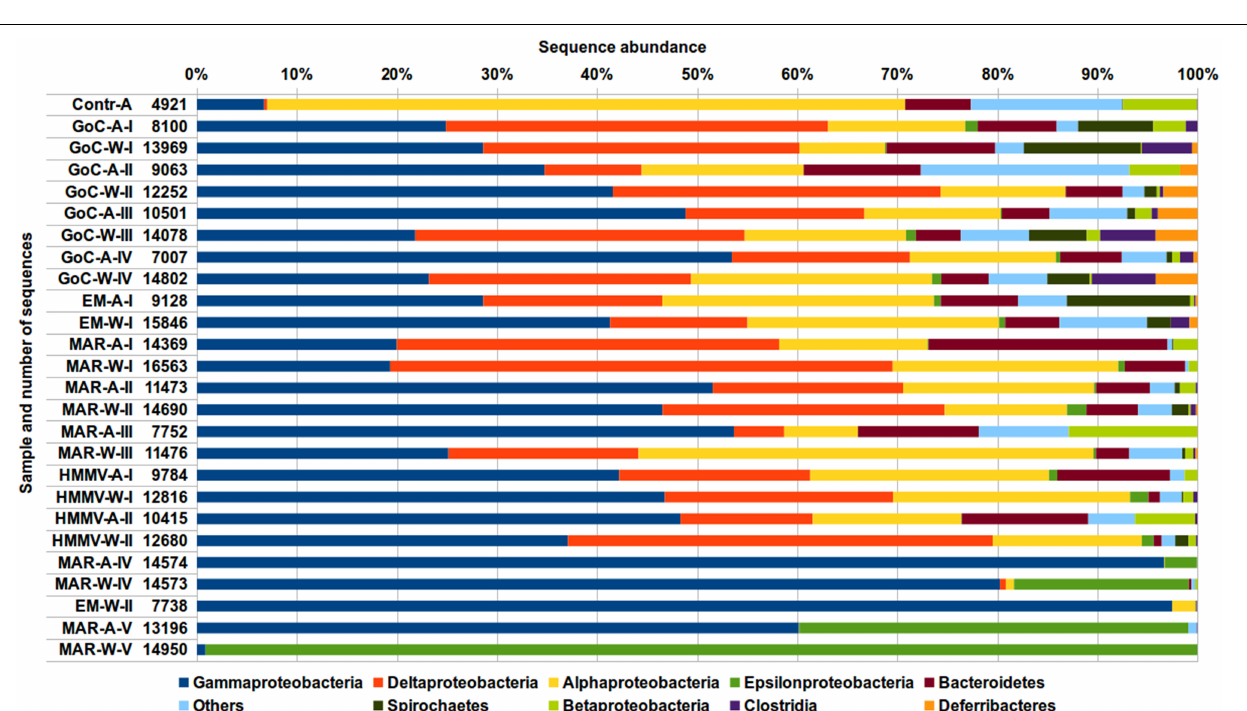
to Table 1 for sample IDs. Abundances are indicated as percentage of total sequences in each sample (numbers close to sample